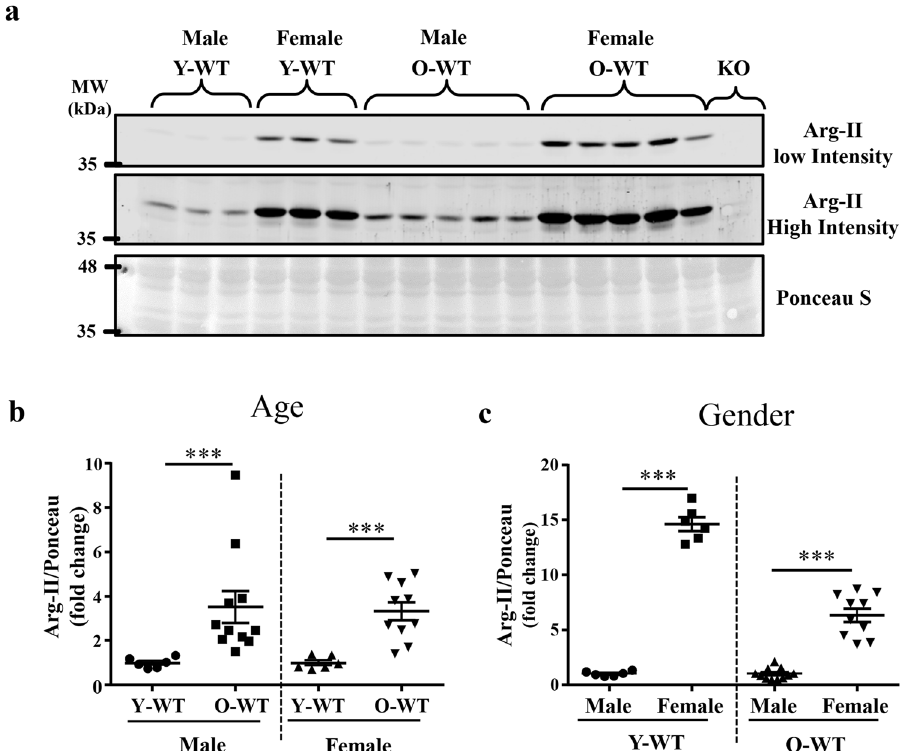
Fig. 1 Age and sex-associated differences in arginase-II protein expression. a Immunoblotting analyses of arginase-II in kidney of male and female WT mice. Two scanning intensities are shown to better visualize the aging- and gender-associated differences in Arg-II levels (low intensity image was used for female mice and higher intensity image was used for male mice quanti fi cation). Kidney from arg-II − / − mice was used as a negative control. Ponceau staining serves as loading control, since actin has a variable expression with aging. b Quanti fi cation is shown in the graphic revealing comparison of young and old mice. c Quanti fi cation is shown in the graphic revealing comparison of male and female mice. The value of male young and male old mice was used as a reference for female young and female old mice, respectively. Y-WT young WT, O-WT old WT, KO arg-II − / − . *** p ≤ 0.001 between the indicated groups. Male: Y-WT, n = 6; O-WT, n = 11; female: Y-WT, n = 6; O-WT, n =